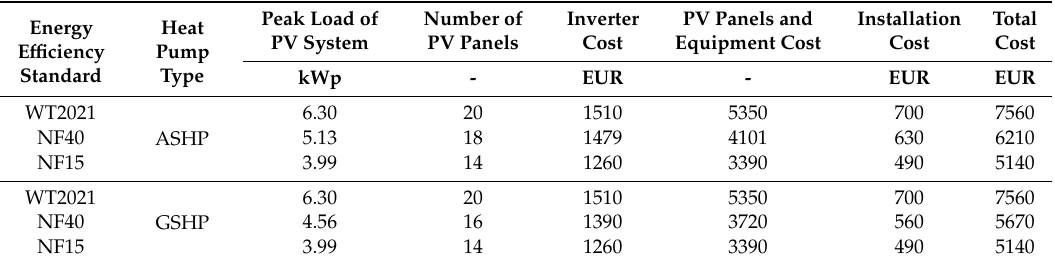
Table 16. The photovoltaic system cost.